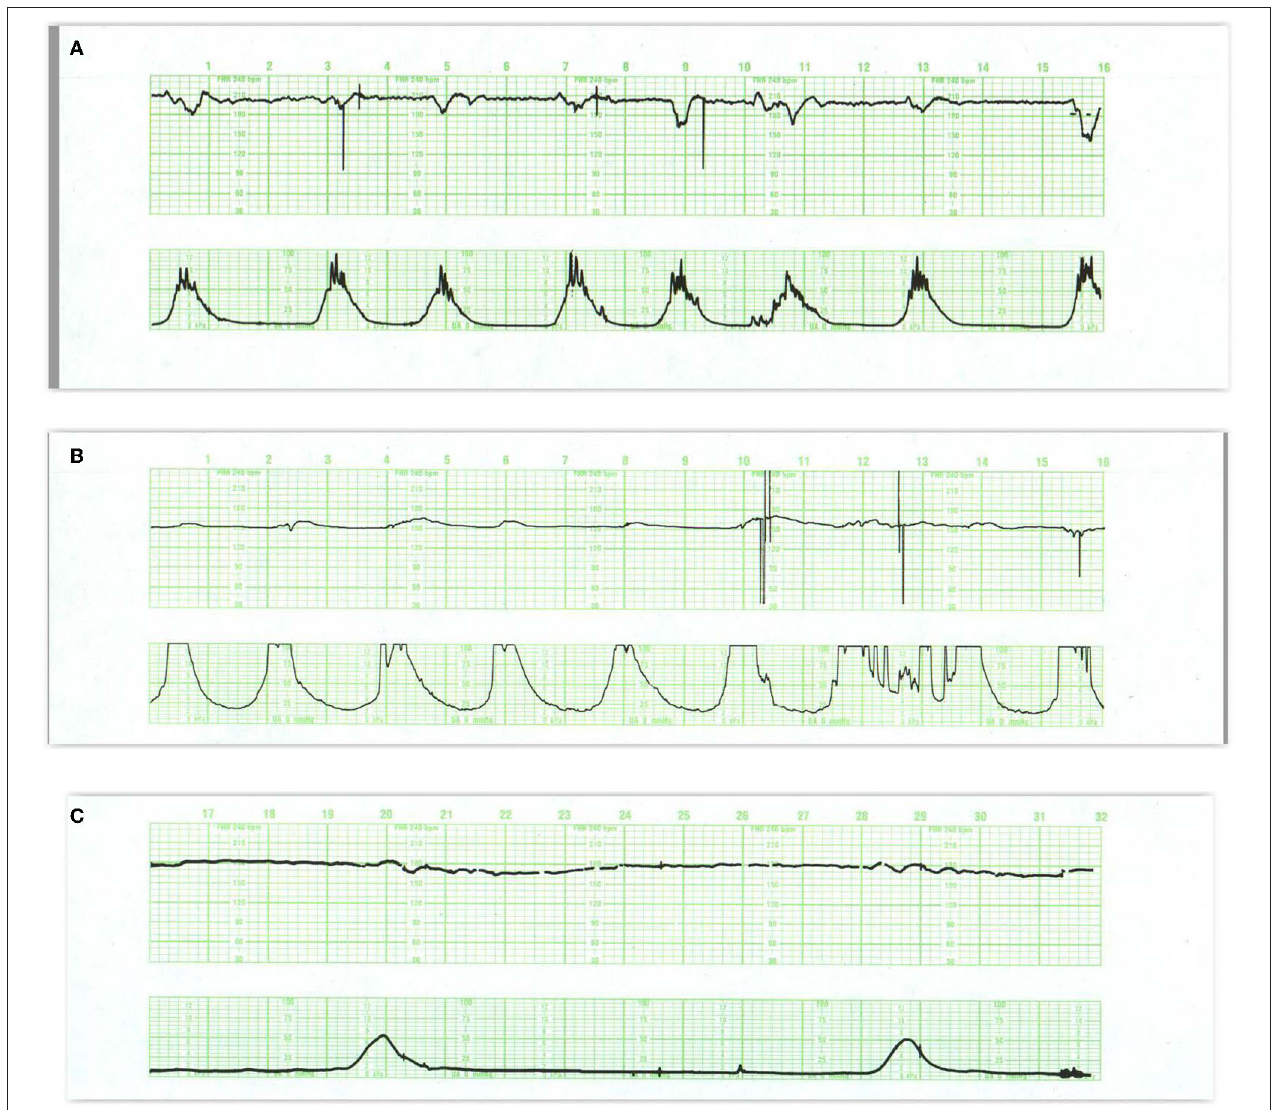
FIGURE 4 | (A) Demonstrates baseline tachycardia and decreased absent short-term variability in an otherwise resilient fetus in a febrile mother. Under normal circumstances, when the baseline heart rate rises, both long- and short-term variability diminish. Notice the accelerations “overshoot” that tend to follow the trivial variable decelerations. Fetal monitor patterns may not be reliable signs of early fetal infection and approaches to treatment of fetal tachycardia vary. Despite the maternal fever, the tracing suggests a resilient infant. The newborn should be evaluated for sepsis. (B) Offers considerable insight into the signs of abnormal neurologic control of the heart rate pattern, not necessarily related to injury. The entire pattern takes place in the second stage of labor; contractions are frequent, and the mother is pushing with each. Despite this assault, the fetus maintains a perfectly stable baseline rate with some accelerations and no decelerations—features that preclude fetal asphyxia. (C) Reveals a markedly abnormal tracing including baseline tachycardia, small variable decelerations with overshoot, and some instability of the heart rate as reflected by the prolonged return to the baseline after the occasional contraction. It is implausible that the tracing immediately preceding this was normal. Scaling − 30 bpm/cm—vertical, 3 cm/min—horizontal—each panel is 16min wide.